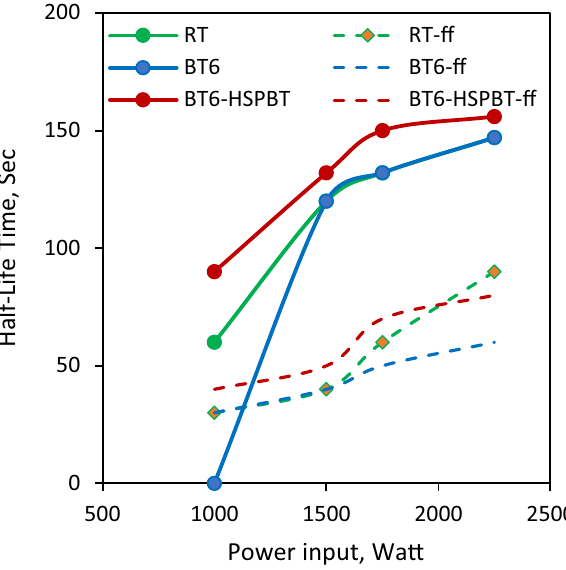
Fig. 8 Effect of addition of fibers and impeller type on half-life time